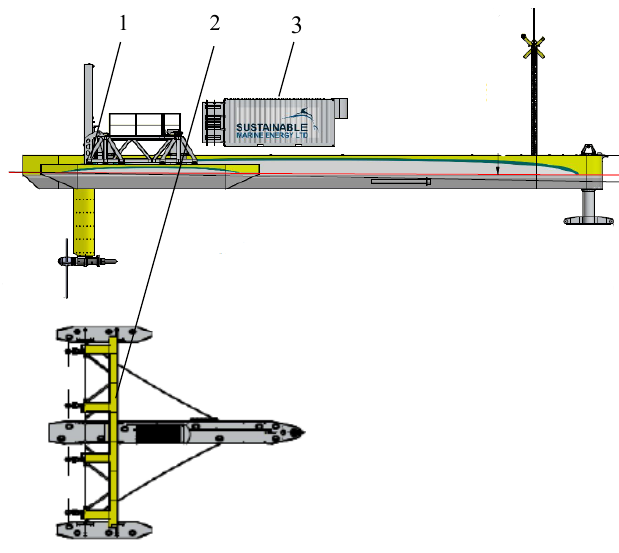
Fig. 8 PLAT-I with instrumentation locations (side and top view) drifting velocity and drifter position along each drifter tra- jectory [13]. Drifters were hand-released from a small ves- sel just downstream of PLAT-I 4.63 at different locations parallel to the platform’s cross-deck. Each drift lasted at least 90 s with distance covered ranging from 130 m to 490 m depending on tidal stage (20 d tip to 78 d tip , or 10 d equ to 40 d equ ). Data were collected along 390 drifts at different phases of the